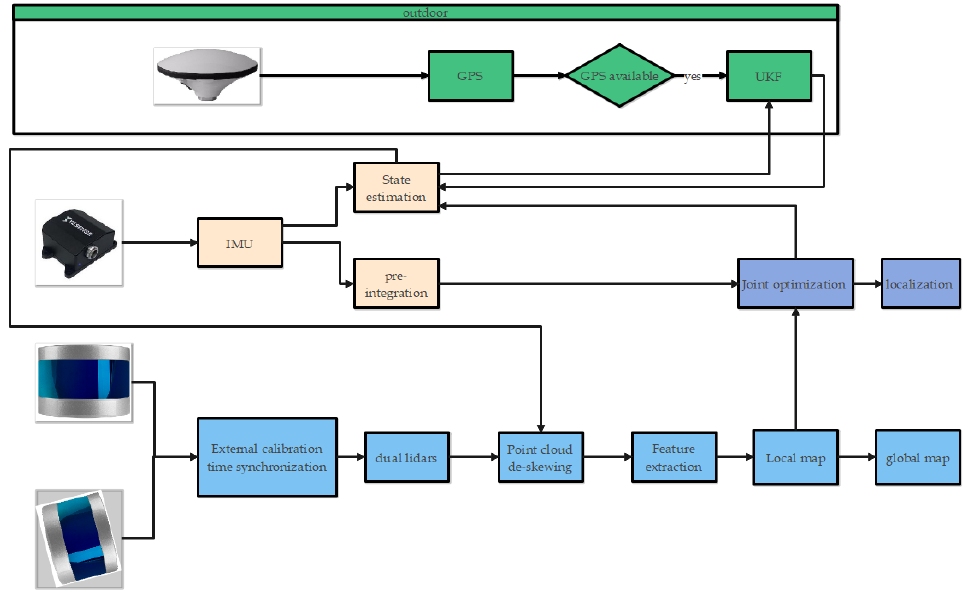
Figure 2. An overview of our proposed framework.